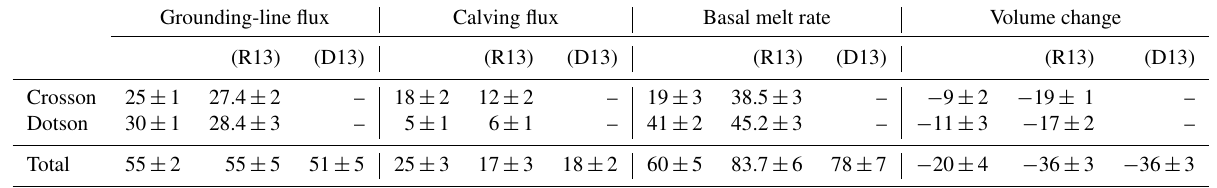
Table 1. Comparison of fluxes and melt between this study (first columns) and those from Rignot et al. (2013) (R13) and Depoorter et al. (2013) (D13). Values from this study are for 2010, while the Depoorter et al. values are for 2009, and the Rignot et al. values are for 2007–2008. Columns show grounding-line flux, calving flux, basal melt rate, and volume change. All values are given in gigatons per year (Gtyr − 1 )